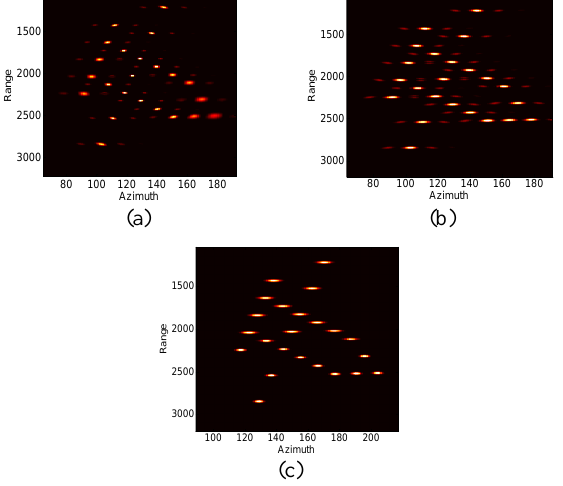
Figure 2 (a) image obtained by the classic method; (b) image obtained by conducting MTRC on (a); (c) image obtained